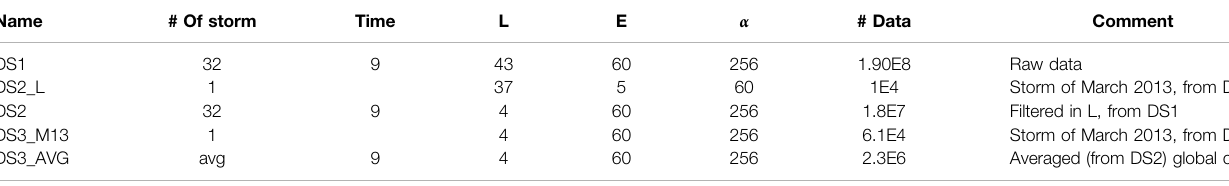
TABLE 1 | List and properties of the various datasets in use.